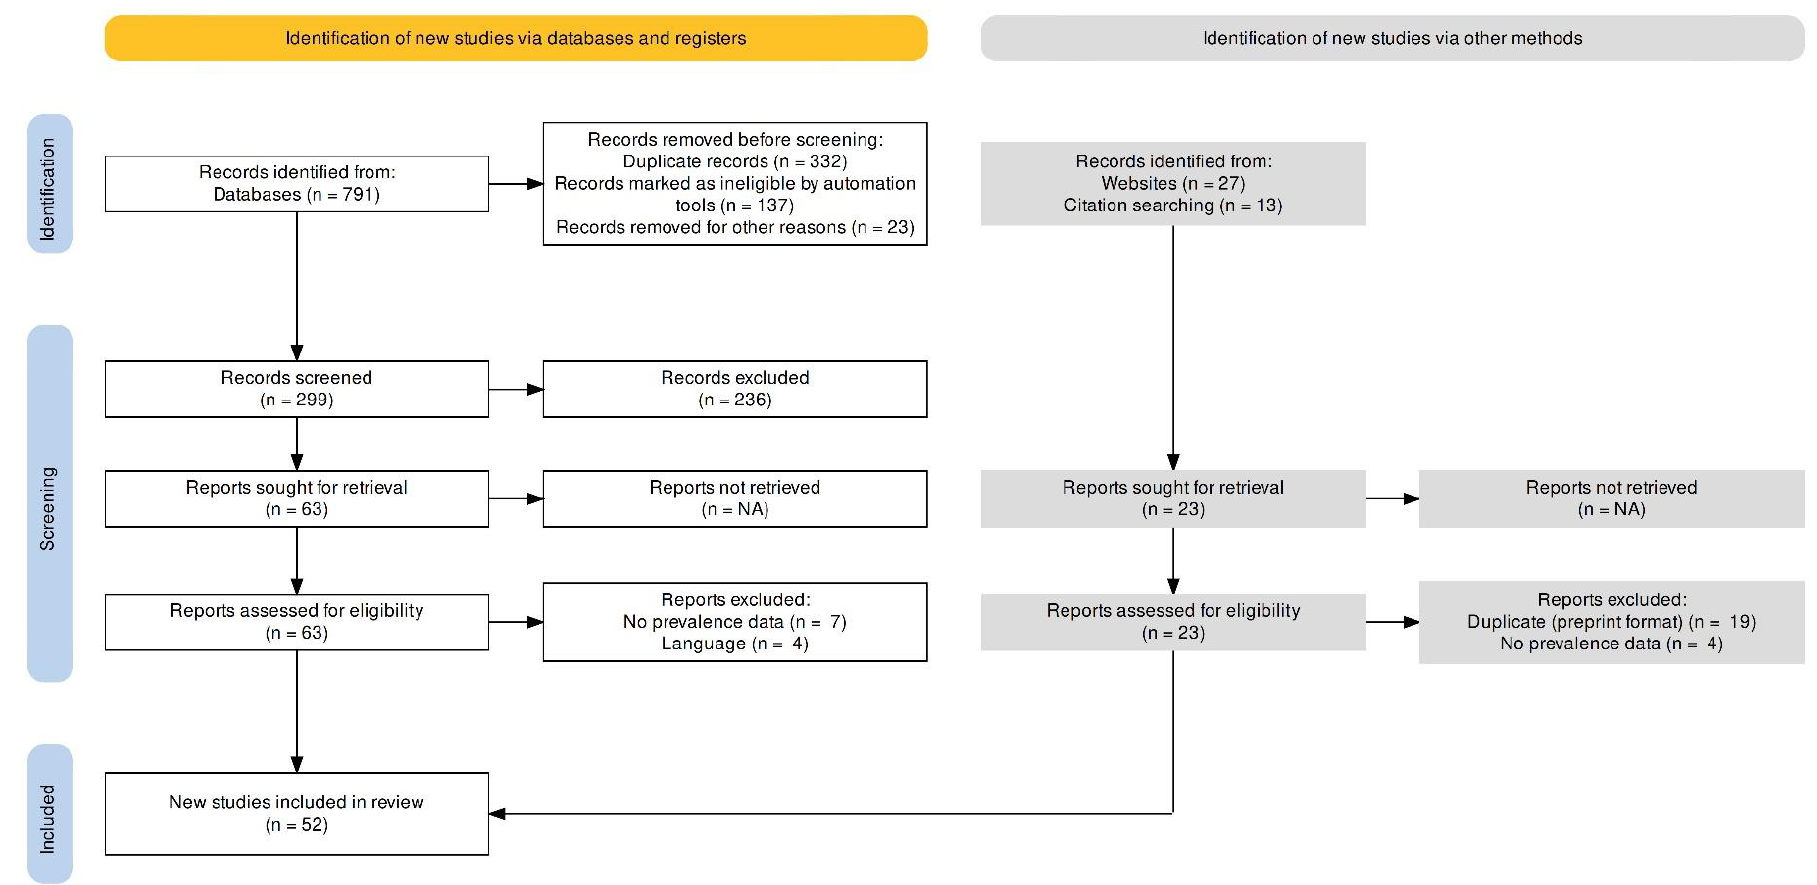
Figure 1. PRISMA 2020 flow diagram for study selection.